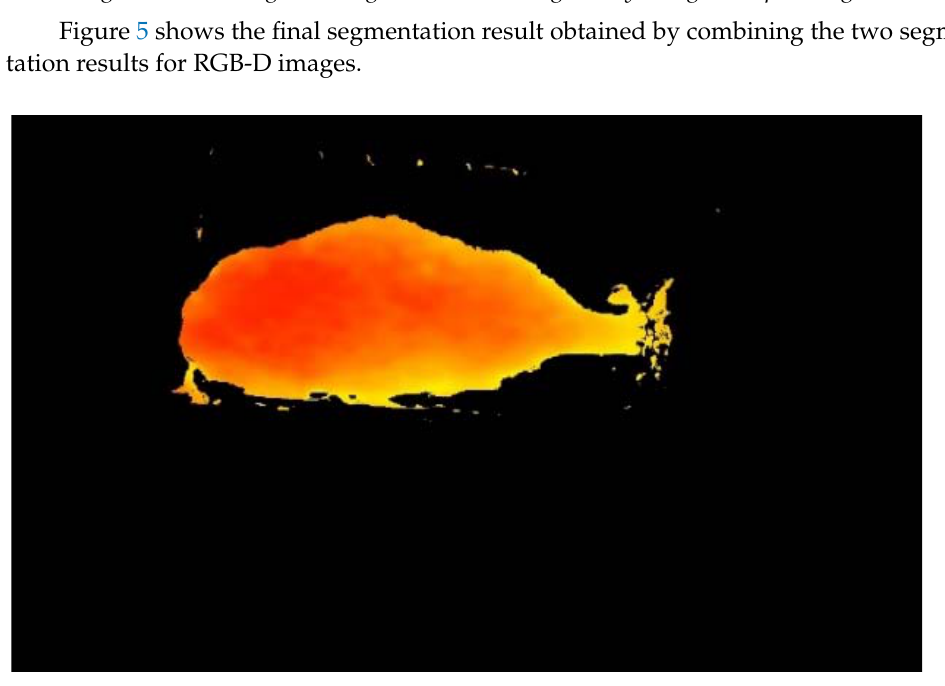
results using the following procedure.